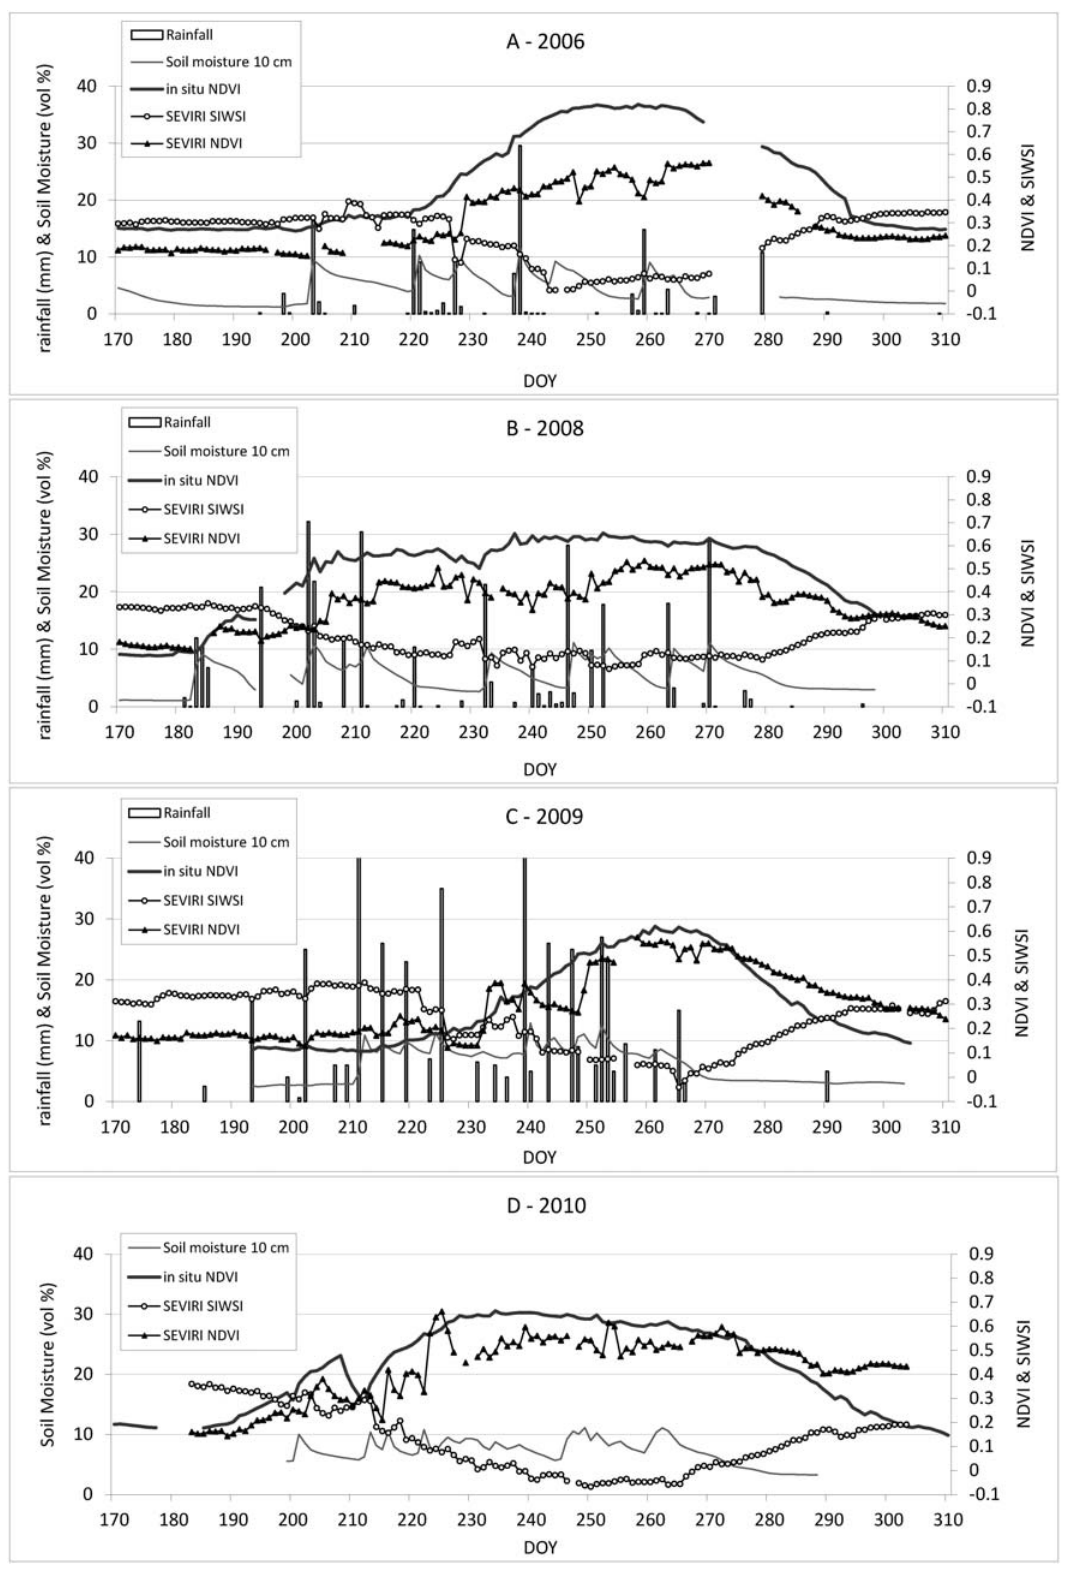
Figure 3. Dahra growing seasons of ( A ) 2006, ( B ) 2008, ( C ) 2009, and ( D ) 2010. For the first three years rainfall is shown, and for all four years soil moisture in vol.% at 5 or 10 cm depth is shown. Both in situ Normalized Difference Vegetation Index (NDVI) and Spinning Enhanced Visible and Infrared Imager (SEVIRI) NDVI are shown together with SEVIRI Shortwave Infrared Water Stress Index